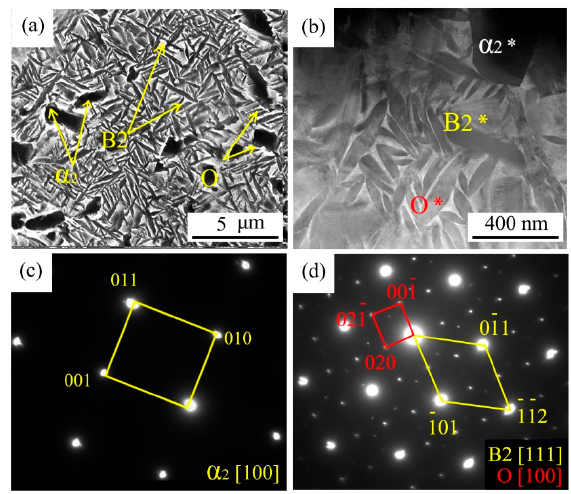
Figure 2. SEM and TEM micrographs of the as-rolled Ti 2 AlNb sample: ( a ) SEM image; ( b ) bright TEM field image; ( c ) and ( d ) selected area electron diffraction (SAED) patterns of the selected zone marked in ( b ) showing the matrix with the α 2 phase, B 2 phase, and O phase.